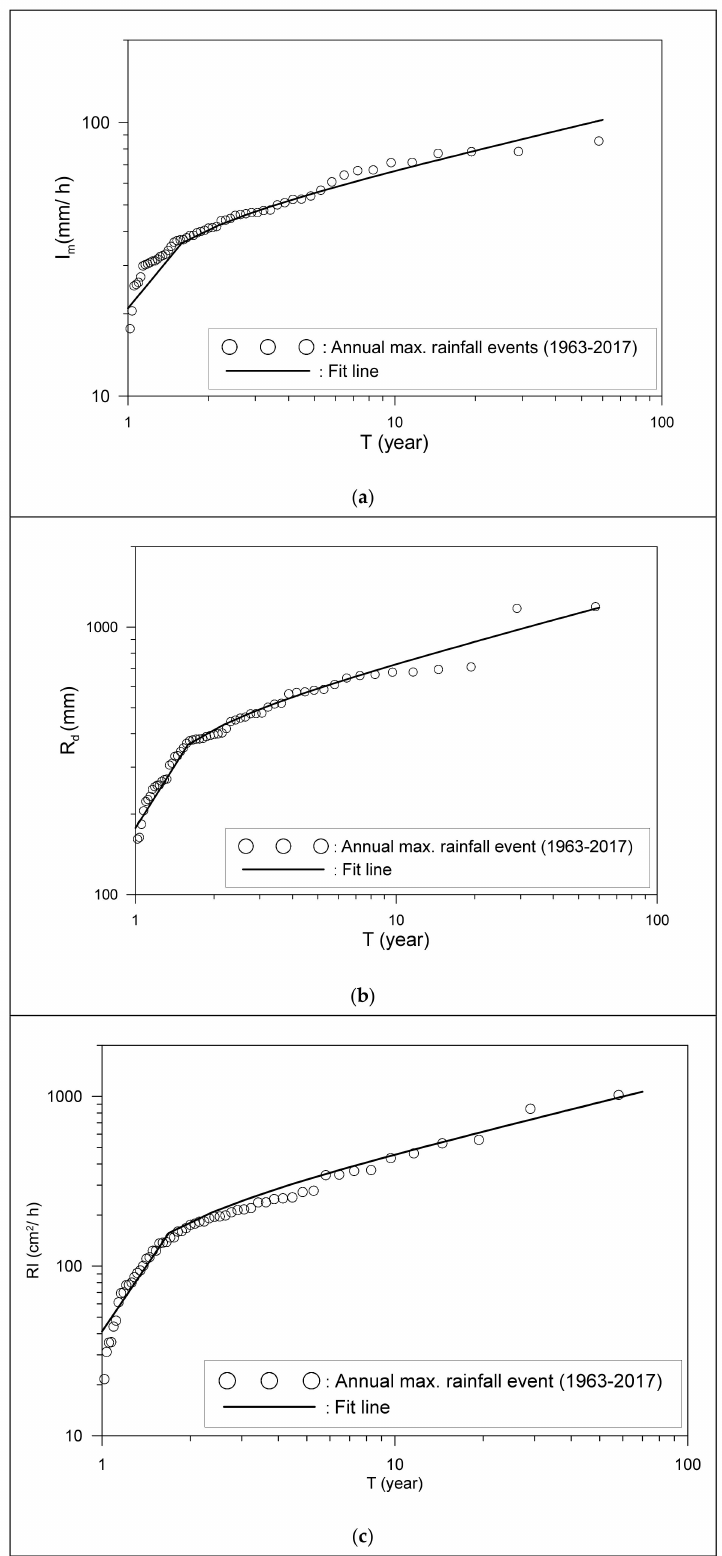
Figure 2. Return period (T) of rainfall index in the Chenyulan watershed. Three rainfall indexes, I m , R d , and RI, were used. ( a ) Annual maximum hourly rainfall depth (I m ) between 1963–2017; ( b ) annual maximum 24-h rainfall amount (R d ) between 1963–2017; and ( c ) annual maximum RI (I m × R d ) between